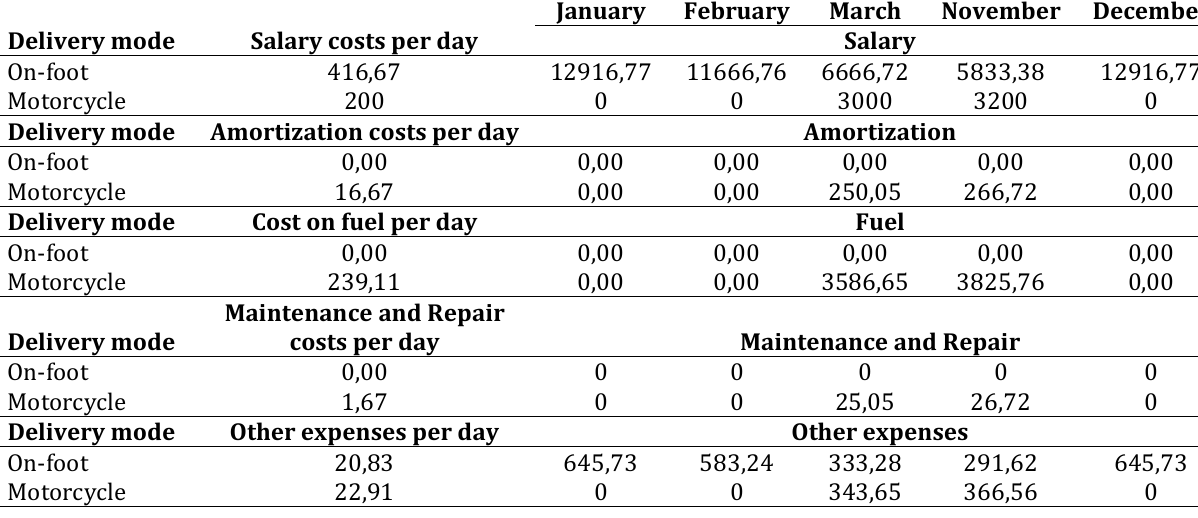
Table 9: Internal costs of combination “On-foot+Motorcycle” for season with difficult weather